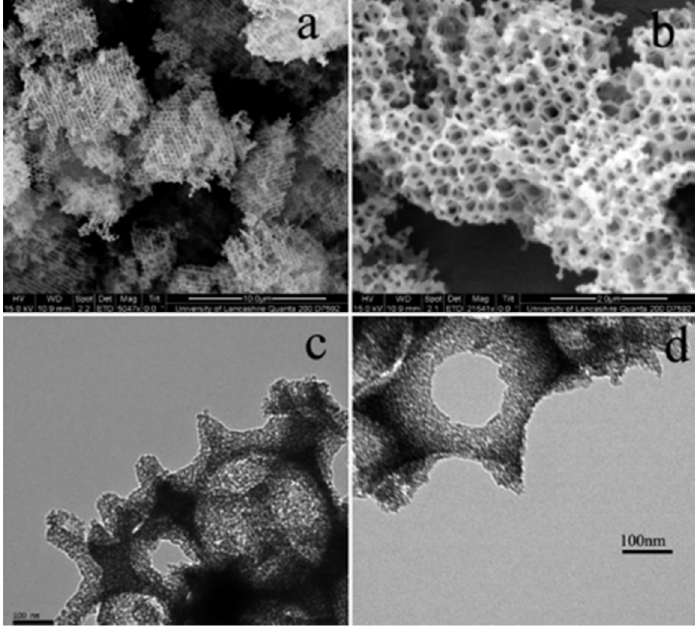
Figure 8. Electron micrographs of the magnetic composites: SEM ( a , b ); TEM ( c , d ) [103]. Tran et al. [33] immobilized a lipase from Burkholderia sp. on magnetic nanoparticles to catalyze